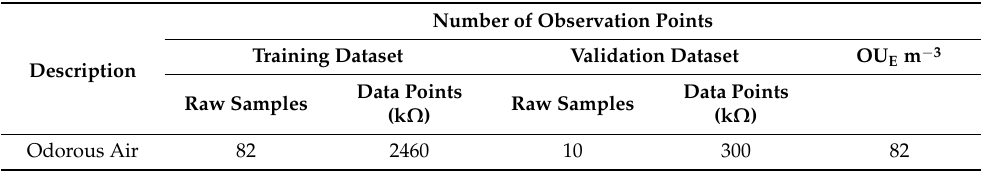
Table 2. Size of the experimental dataset for each of the 13 MOS measurement sensors.